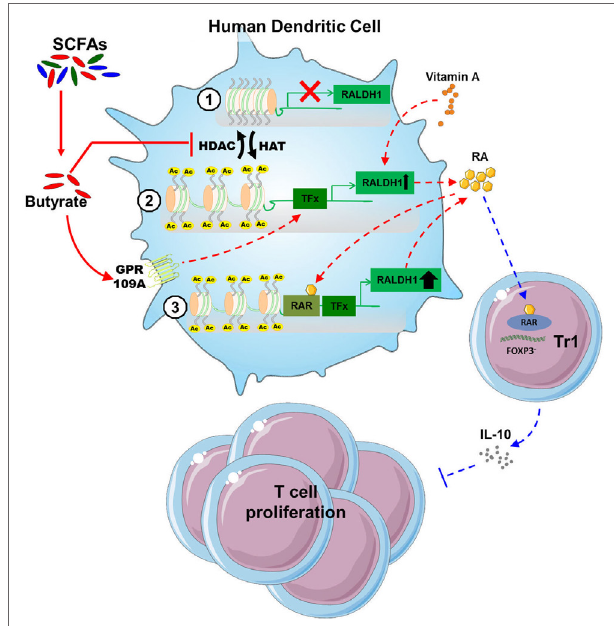
FigUre 7 | Proposed model of how butyrate conditions human dendritic cells (DCs) to prime type 1 regulatory T cells (Tr1). (1) Butyrate inhibits histone deacetylases (HDAC) activity in DCs to enhance net histone acetylation, resulting in opening of the gene locus of retinaldehyde dehydrogenase 1 (RALDH1) in human DCs. (2) The now open promoter region of RALDH1 enables butyrate through signaling via G protein-coupled receptor (GPR) 109A to promote transcription and expression of RALDH1. (3) This initial RALDH1 expression results in retinoic acid (RA) synthesis that further reinforces RALDH1 expression. Butyrate-induced RALDH1 expression endows human DCs with the capacity to prime IL-10-producing type 1 regulatory T